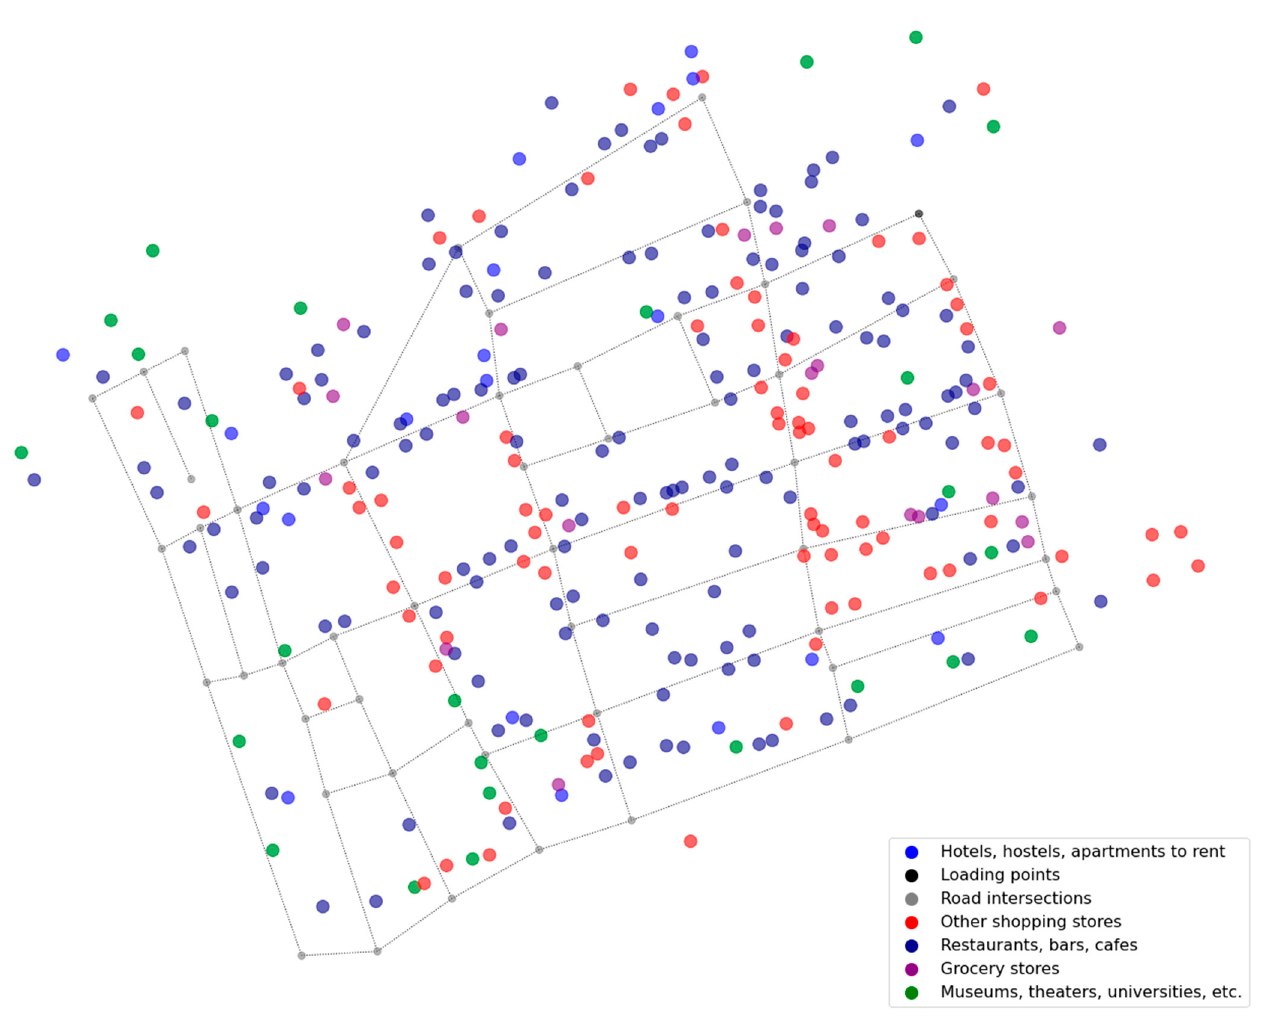
Figure 3. Location of the clients and the road network of the central district of San Sebastian. The structure of potential clients and the road network in Dubrovnik are conditioned by the unique location of the studied city area, which is the touristic Old Town district rounded by city walls. The most numerous groups of clients in Dubrovnik are restaurants and cafes (35.8% of the total number) along with hotels and hostels (34.8% of businesses). The part of stores and shops in the area is minor: just 2.1% of grocery stores and 7.1% of other types of stores. The lack of transport roads may be observed in the southern part of the Old Town of Dubrovnik: due to the terrain relief and peculiarities of medieval urban architecture, the streets in that part have stairs available only for pedestrians. The other feature of the transport network of the studied area is a single inlet to the district available for transport (main city gate). As may be observed in Figure 4, shops and stores in the Old Town district of Dubrovnik are located near the roads, as their supply in other locations would be quite